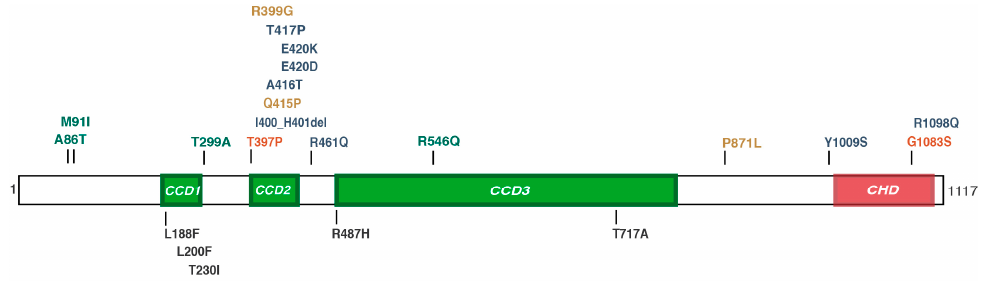
Figure 1. Schematic representation of the SPECC1L protein. Domain structure and positions of SPECC1L (Q69YQ0) are obtained from UniProt (www.uniprot.org, accessed on 30 November 2021). CCD1, coiled coil domain 1 (aa 160–280); CCD2, coiled coil domain 2 (aa 394–449); CCD3, coiled coil domain 3 (aa 487–807); CHD, calponin-homology domain (aa 1011–1116). The missense variants yellow—found in OFC, CDH and craniosynostosis patients; red—found in ADOS; green—found in non-syndromic orofacial cleft cases [26,27,34–39].